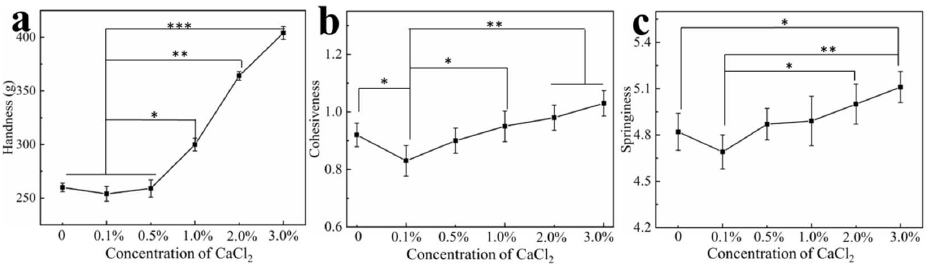
Figure 5. ( a ) Changes in hardness ( a ), cohesiveness ( b ) and springiness ( c ) of the hydrogels as a function of CaCl 2 concentration. * p < 0.05, ** p < 0.01, *** p < 0.001. function of CaCl 2 concentration. * p < 0.05, ** p < 0.01, *** p <